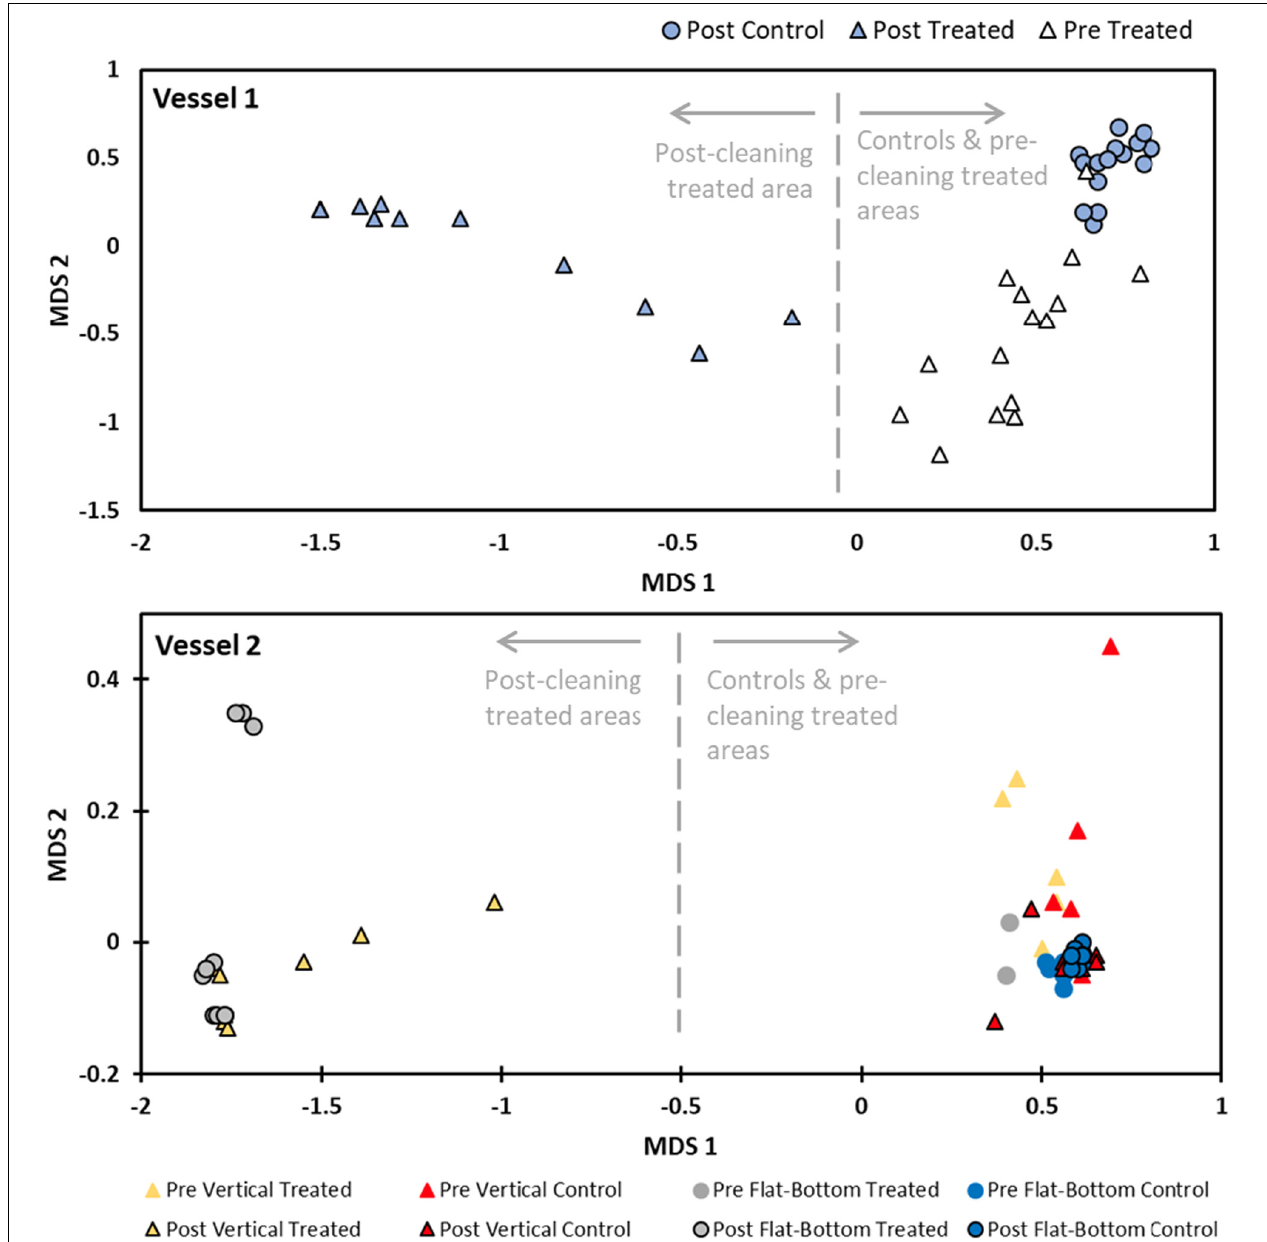
FIGURE 3 | Non-metric multidimensional scaling (nMDS) plots based on biofouling composition in replicate samples for Vessel 1 (top) and Vessel 2 (bottom). There was clear distinction among biofouling communities that were subjected to cleaning compared to those that were not (see text for associated PERMANOVA results).